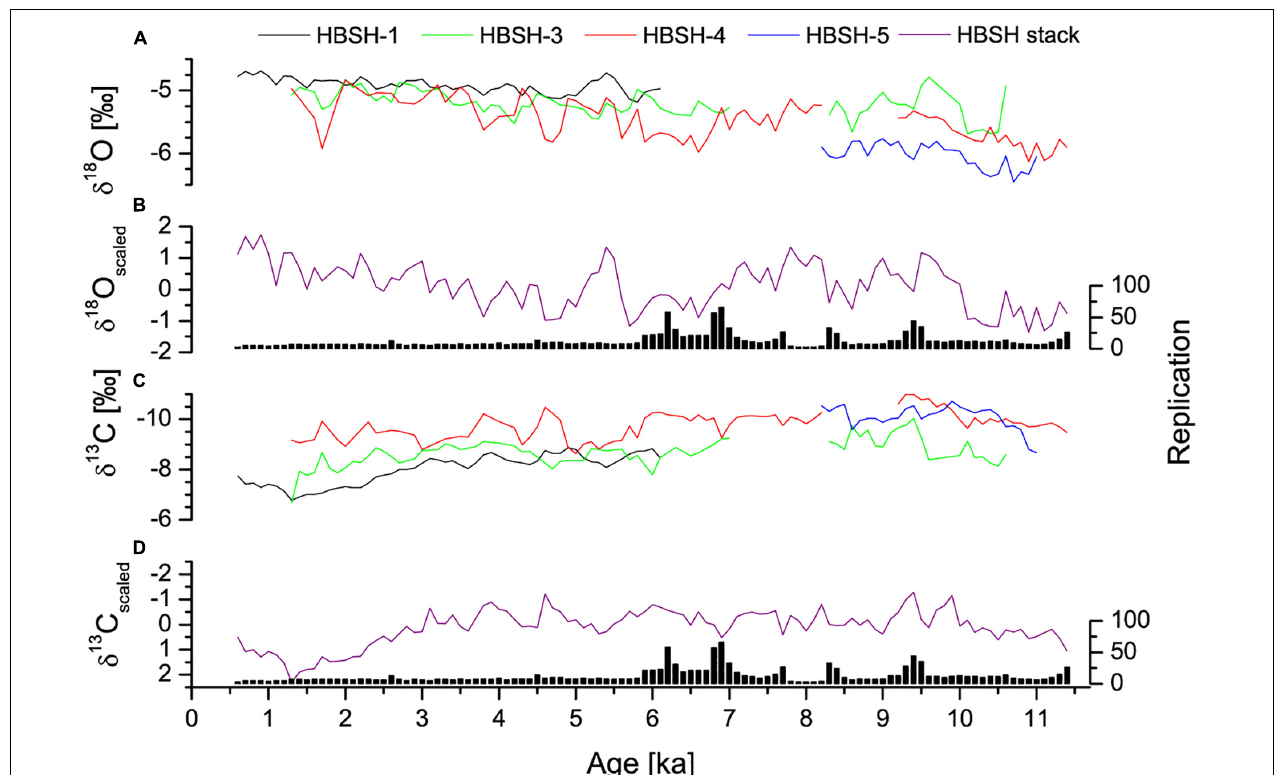
FIGURE 5 | (A) δ 18 O and (C) δ 13 C values averaged by a centennial mean for stalagmites HBSH-1 (black), HBSH-3 (green), HBSH-4 (red), and HBSH-5 (blue). Scaled stable isotope time series for δ 18 O values (B) and δ 13 C values (D) . For all records, the replication indicates the number of stable isotope measurements averaged for the centennial mean for the specific time interval. Note the inverted axis for δ 13